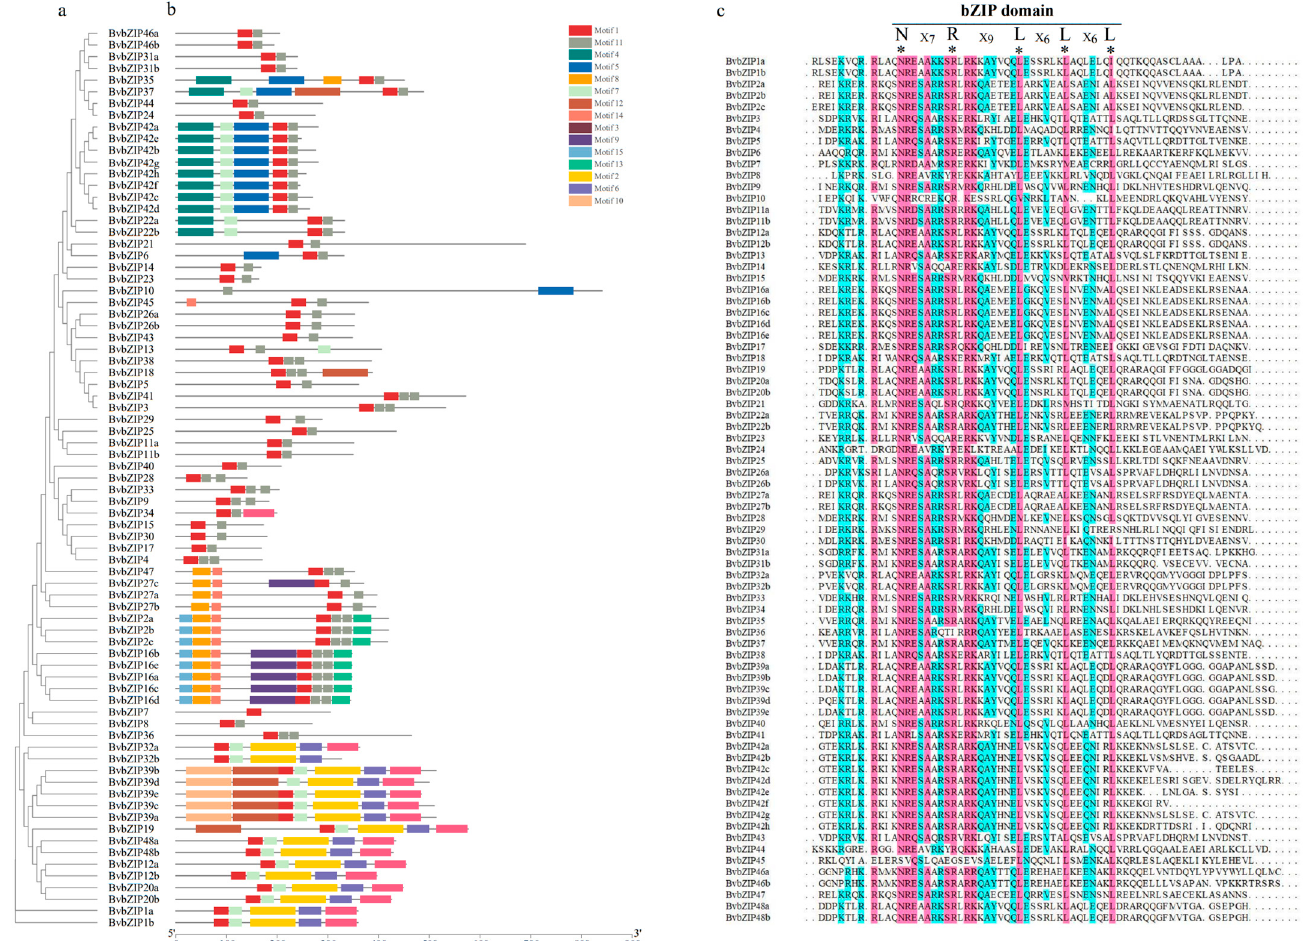
Figure 2. Bv bZIP conserved motifs and domains. ( a ) Phylogenetic tree of Bv bZIP proteins. ( b ) Analysis of conserved motifs of Bv bZIP proteins, in which motifs 1 and 11 correspond to the bZIP domain. ( c ) Multi-sequence alignment results of bZIP conserved domain, with * representing the nuclear localization signal of bZIP conserved domain.